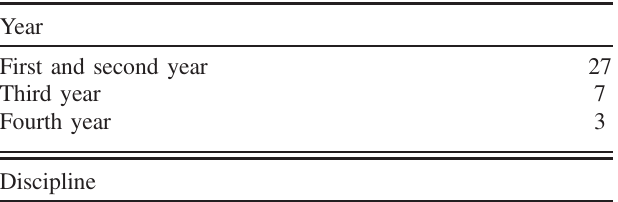
TABLE I. Self-reported year, discipline, race or ethnicity, and gender of students in General Physics in Fall 2018. The “ other ” category for students ’ discipline includes, but is not limited to, psychology, geology, environmental analysis, and